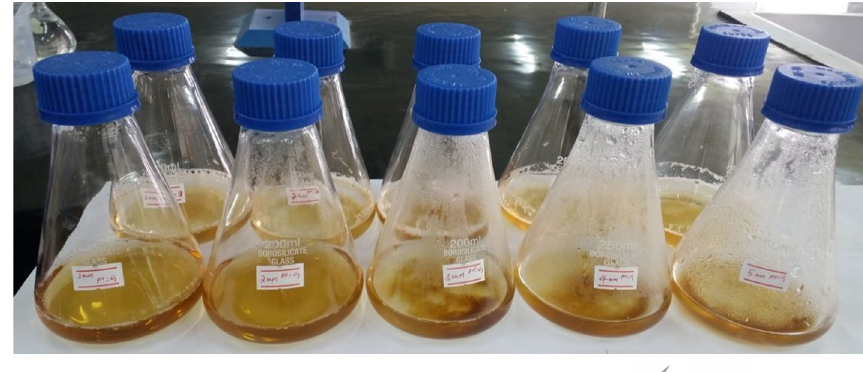
Fig. 2 Synthesis of ZnO NPs at different concentrations of precursor and